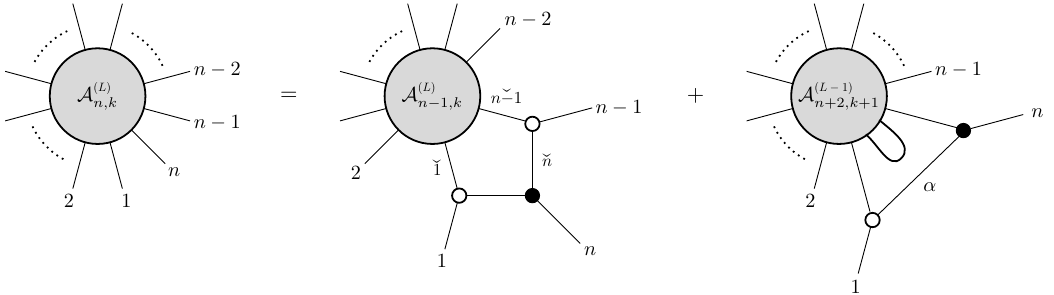
Figure 3 . Recursion for MHV amplitudes using on-shell diagrams, which is equivalent to (3.1). We will say more about on-shell diagrams in section 5.1. The (cid:12)rst term in the recursion is an L -loop ( n (cid:0) 1)-particle MHV amplitude with a soft factor, the second term corresponds to an ( n +2)-particle ( L (cid:0) 1)-loop NMHV amplitude in the forward limit. In the (cid:12)gure, the black and white vertices represent 3-particle MHV and MHV amplitudes, and the edges signify integrals over on-shell